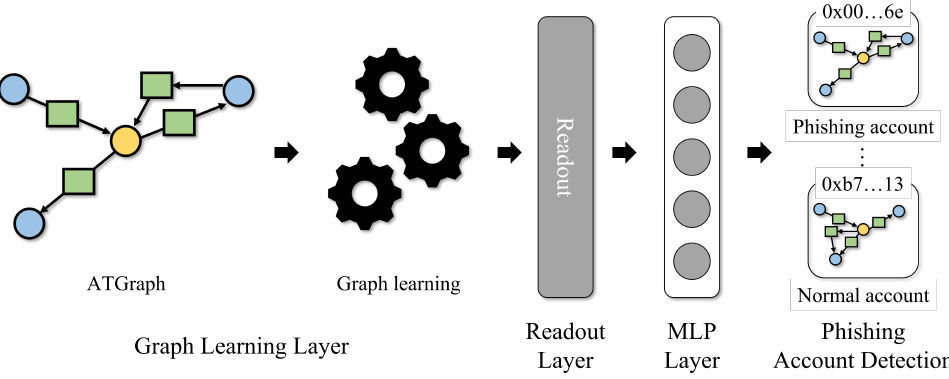
Figure 4. The overall processes of the graph learning-based Ethereum phishing account detection